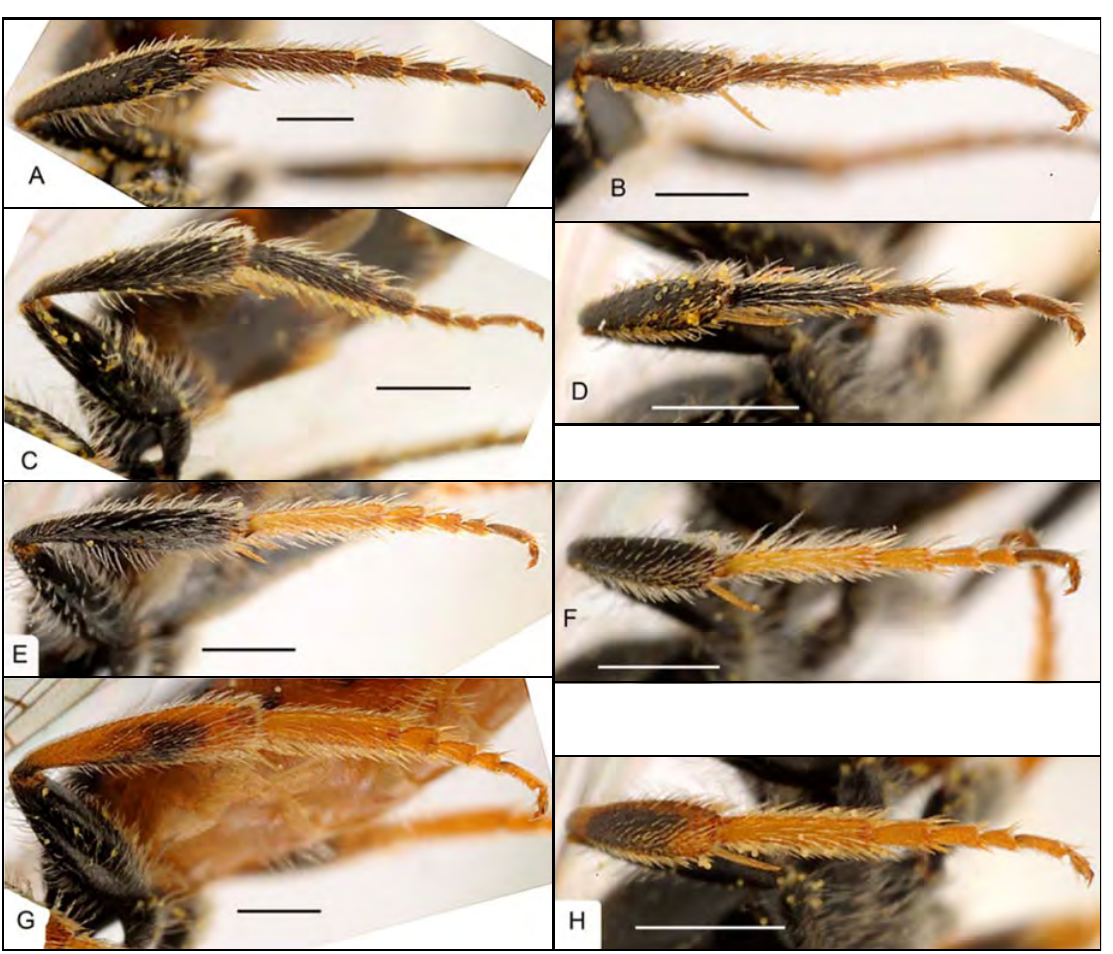
Fig. 14. ♂ hind legs (left) and mid legs (right). — A-B . Lasioglossum ( Capalictus ) mosselinum (Cocke- rell, 1945) . — C-D . Lasioglossum ( Capalictus ) timmermanni sp. nov. — E-F . Lasioglossum ( Capalictus ) hantamense sp. nov. — G-H . Lasioglossum ( Capalictus ) tigrinum sp. nov. Scale line = 0,5